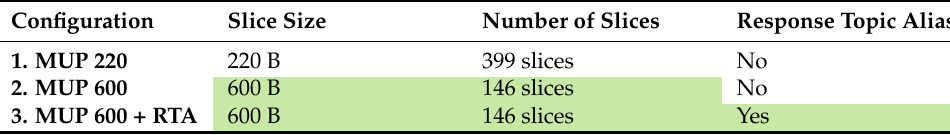
Table 6. MYNO Update Protocol (MUP)